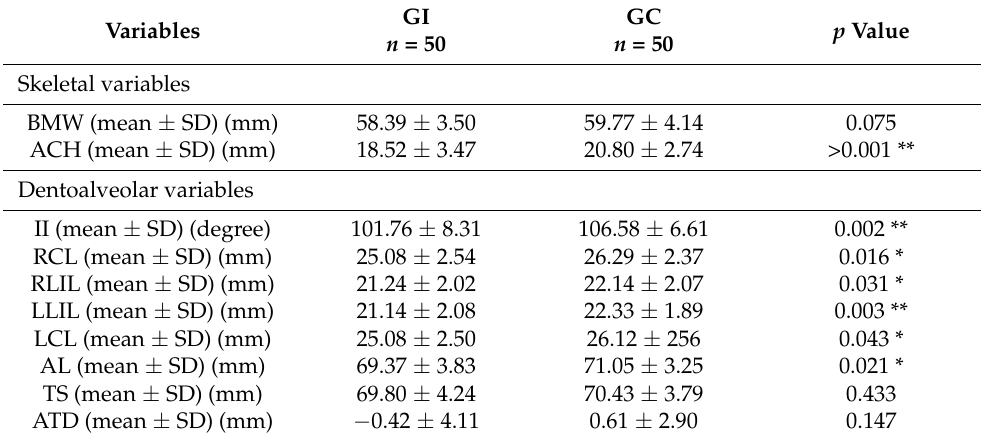
Table 3. Comparisons of the skeletal and dentoalveolar variables of the GI and GC ( n = 100).